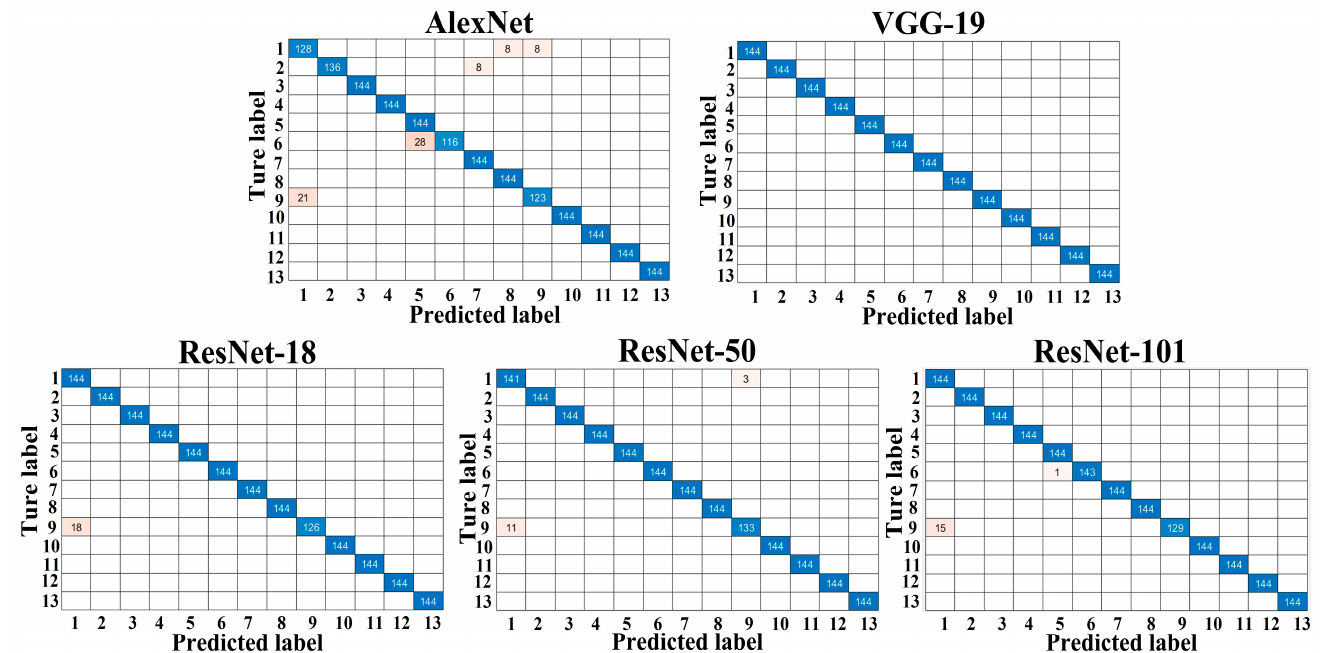
Foods 2023 , 12 , x FOR PEER REVIEW Figure 2. Confusion matrix of the different trained models for dataset A. Figure 2. Confusion matrix of the different trained models for dataset A.